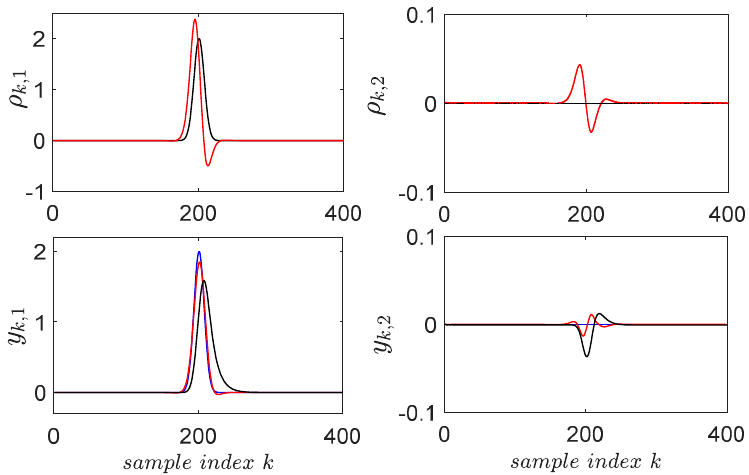
∗ [ 1 ] ∼ [ 1 ] [ 1 ] P , Y [1] }: y d and y d (blue); y 0 , y 0 , ρ 0 , ρ 0 (black); y 30 k ,1 k ,2 k ,1 k ,2 k ,1 k ,2